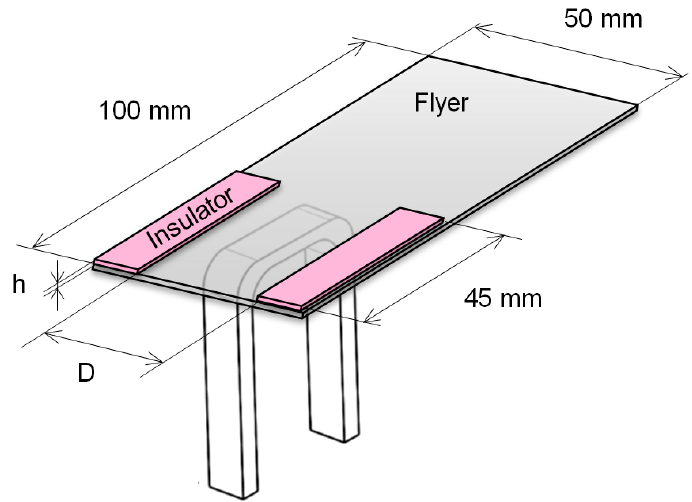
Figure 6. Magnetic Pulse Welding configuration with linear coil.